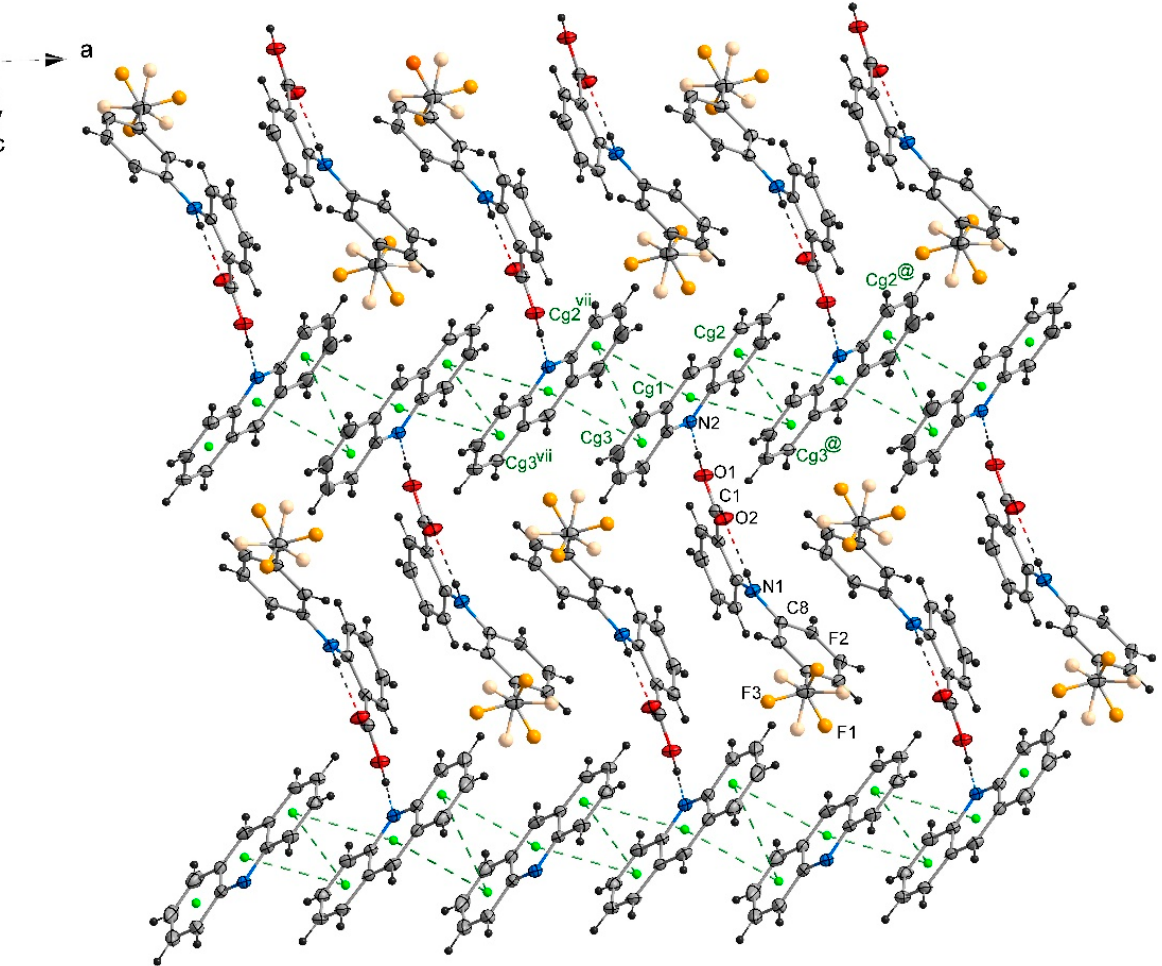
Figure 2. Packing diagram of crystal 1 viewed down the [010] direction showing arrangement of the complexes of acridine and flufenamic acid. Stacking interactions of acridine molecules are shown by green dashed lines linking centers of aromatic rings (centroids of rings-Cg-marked as green balls; Cg1 (N2/C21/C26/C27/C28/C33), Cg2 (C21/C22/C23/C24/C25/C26), Cg3 (C28/C29/C30/C31/C32/C33)). Symmetry codes: @ = − x, − y + 2, − z; vii = − x + 1, − y + 2, − z.